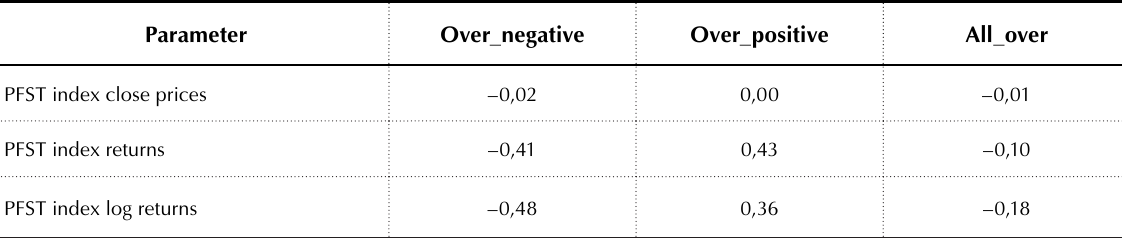
Table 3. Results of the correlation analysis between the frequency of overreactions and different PFST index